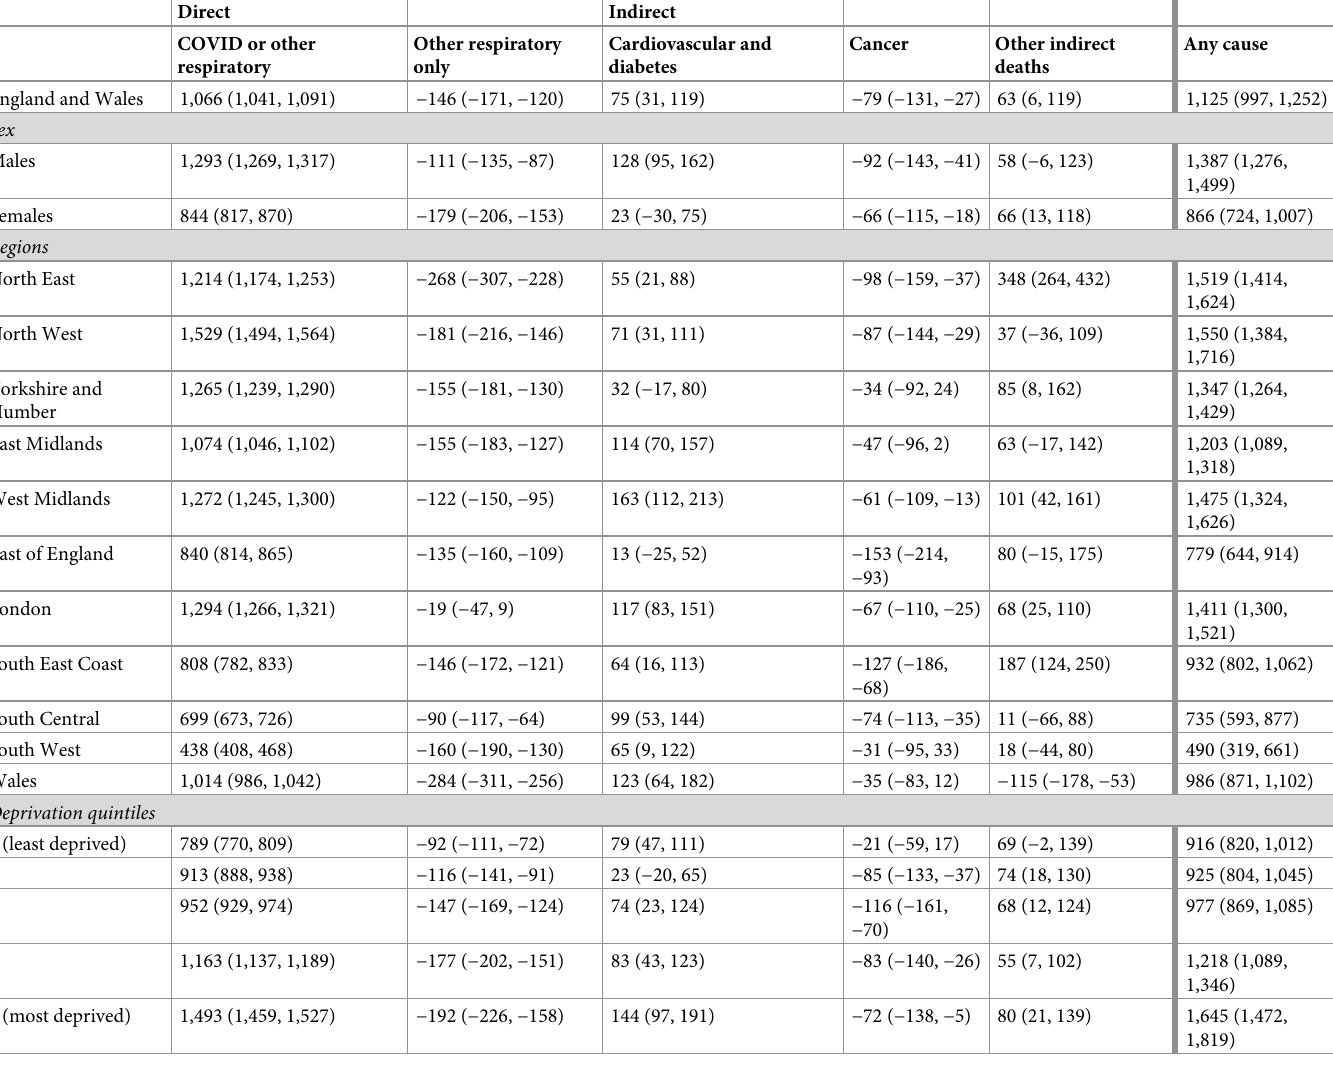
Table 2. Estimated excess YLL (95% confidence intervals), of direct, indirect, and total excess deaths per 100,000 population, weeks 11 to 52, 7 March 2020 to 25 December 2020.